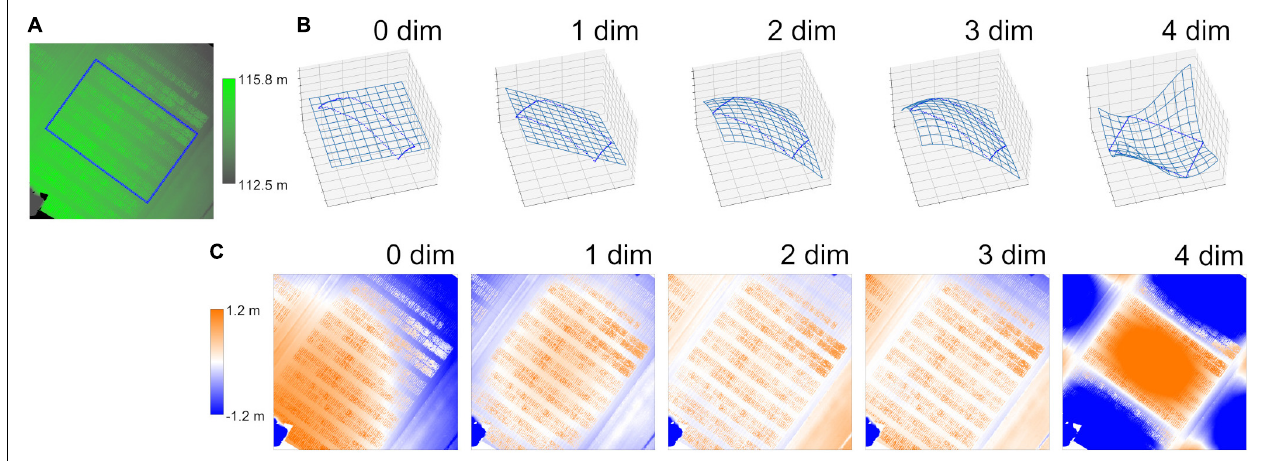
FIGURE 5 | An example of the process involved in method M3. (A) A digital surface model (DSM) of Field 1. Blue rectangles show ROIs around the field (outer ROIs). (B) Digital terrain models (DTMs) fitted to polynomial surfaces. Blue points show coordinates of the outer ROIs and meshes show the fitted DTMs. “ n dim” shows the dimension of the polynomial surface. (C) Crop height models (CHMs) calculated as the difference between DSM and DTMs. These figures were created with the dataset of rep. 1 on Field 1 in the vegetative stage.